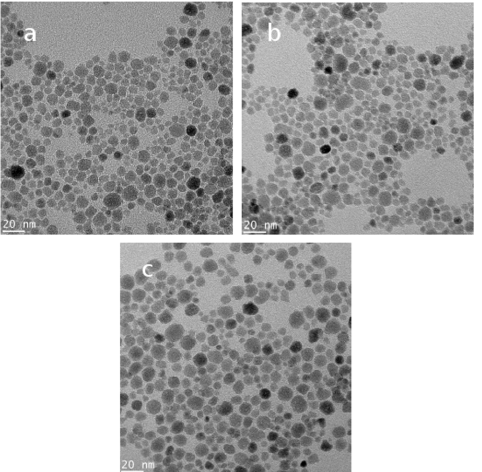
Fig 4. TEM images of (a) bare, (b) positively charged and (c) negatively charged